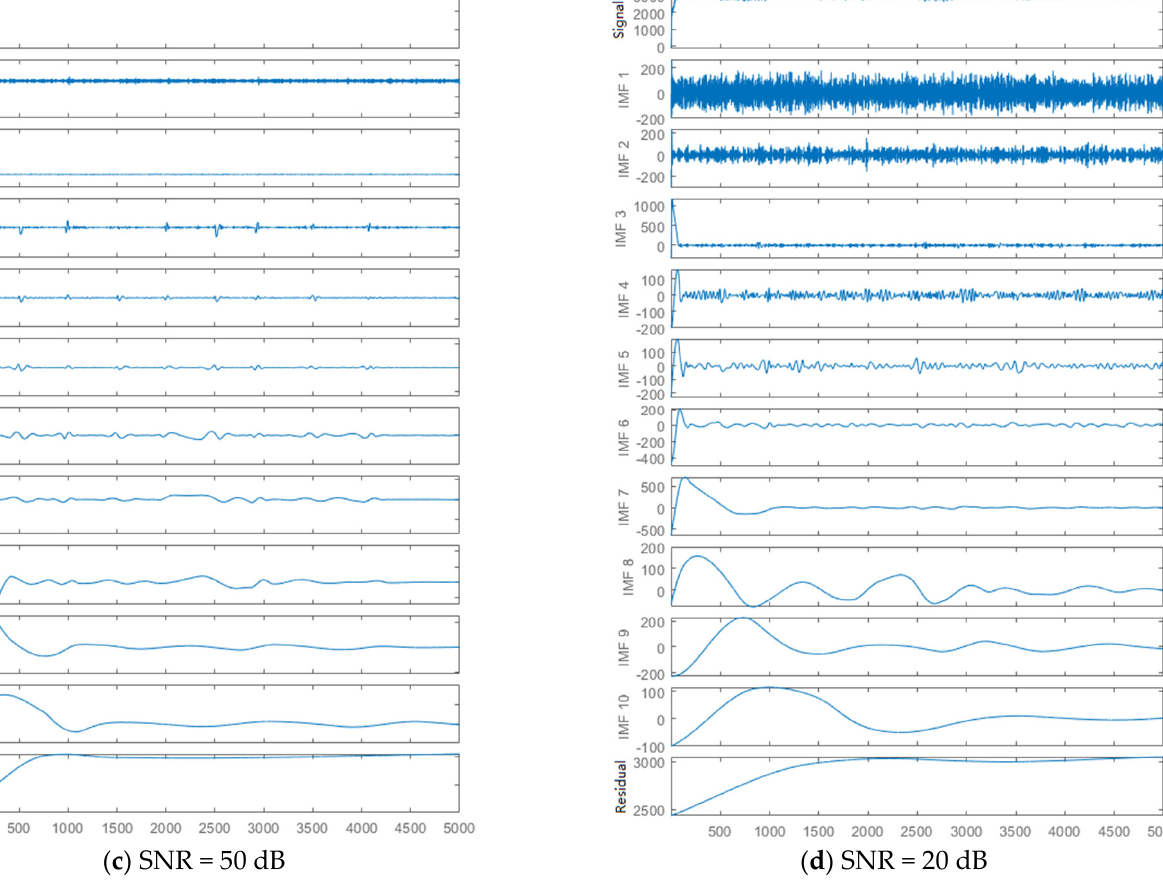
Figure 12. Comparison of EMD results of fault state signals in different noise environments.